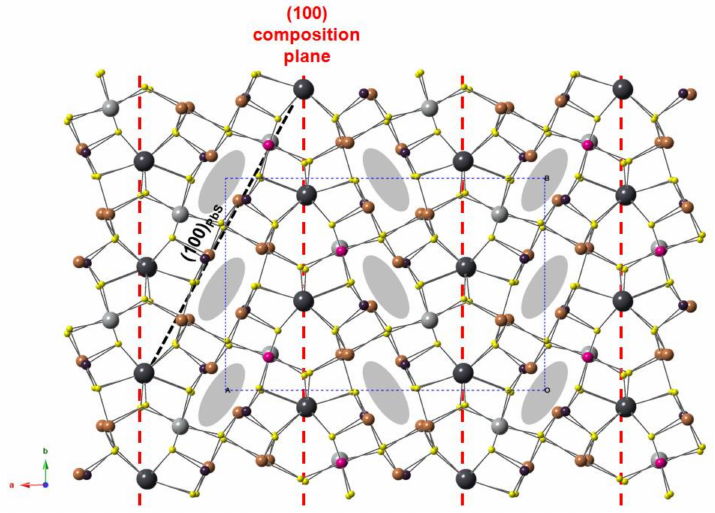
Figure 3. General organization of oyonite, as seen down c . Within each slab, separated by the (100) composition plane, (100) PbS planes occur (one of them is shown by the black dashed line). Lone electron-pair micelles are shown as grey ellipses.